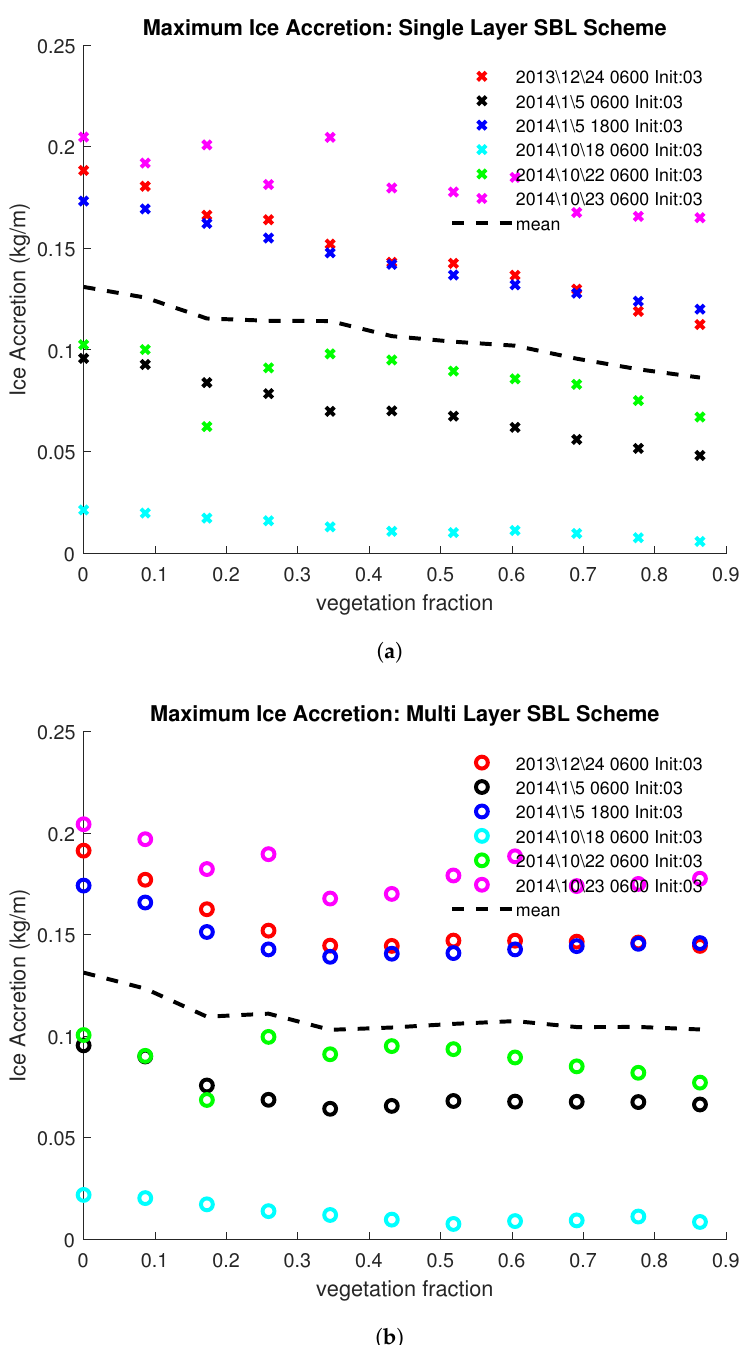
Figure 4. Absolute values of maximum ice accretion (kg/m) for the single- ( a ) and multi layer ( b ) SBL schemes. The black dashed line indicates the mean value for each vegetation